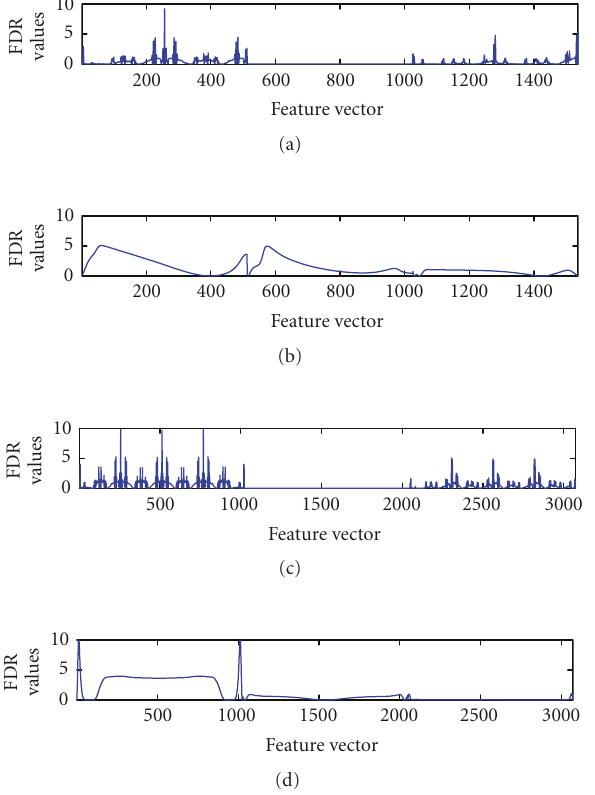
Figure 14: FDR values related to (a) (cid:9) c u , (b) (cid:9) c u feature vectors when the disturbance is oscillatory transient.